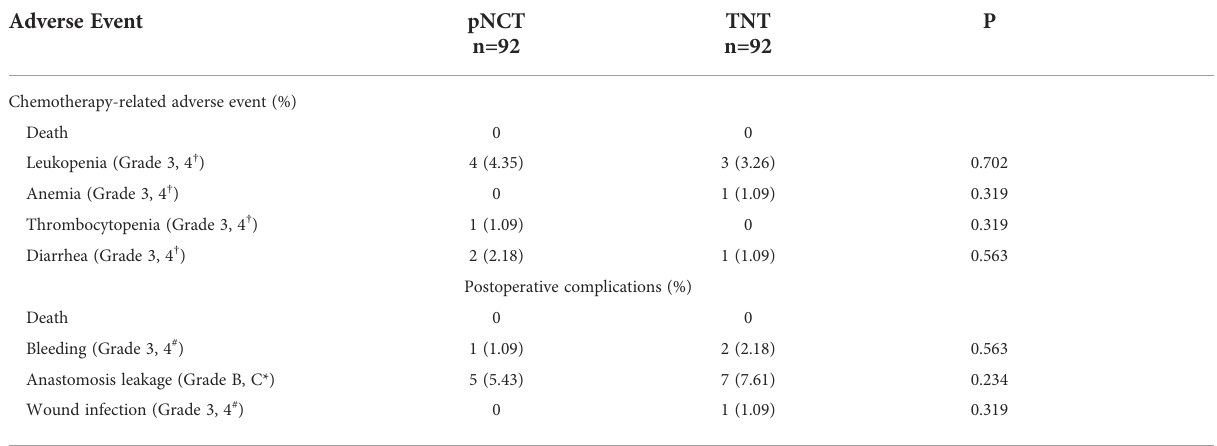
TABLE 3 Comparison of toxicity and adverse